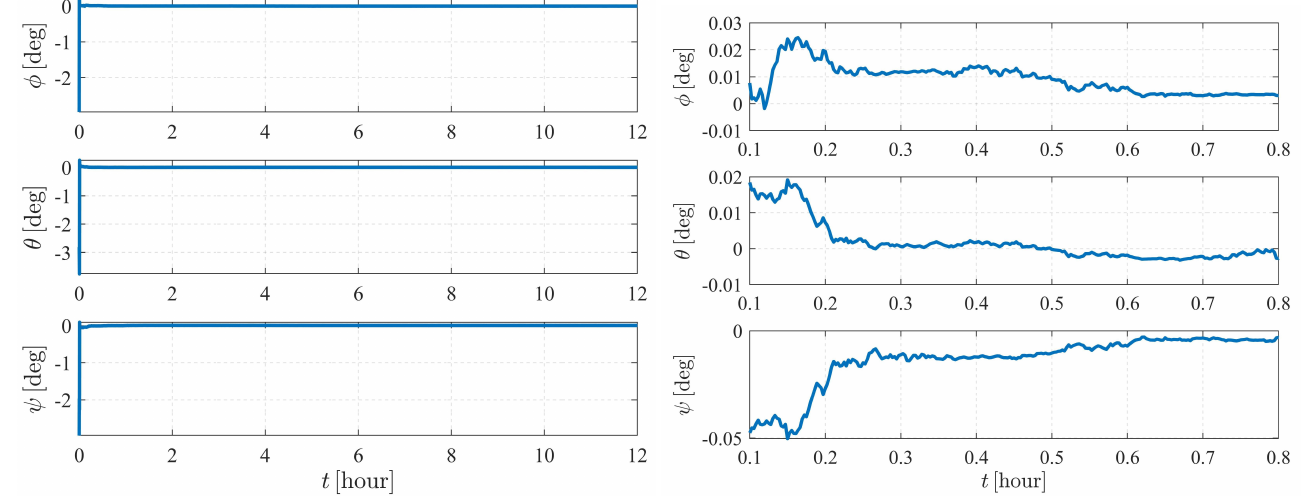
Figure 6. Attitude determination errors of case II (nonperturbation) and the corresponding larger plot.